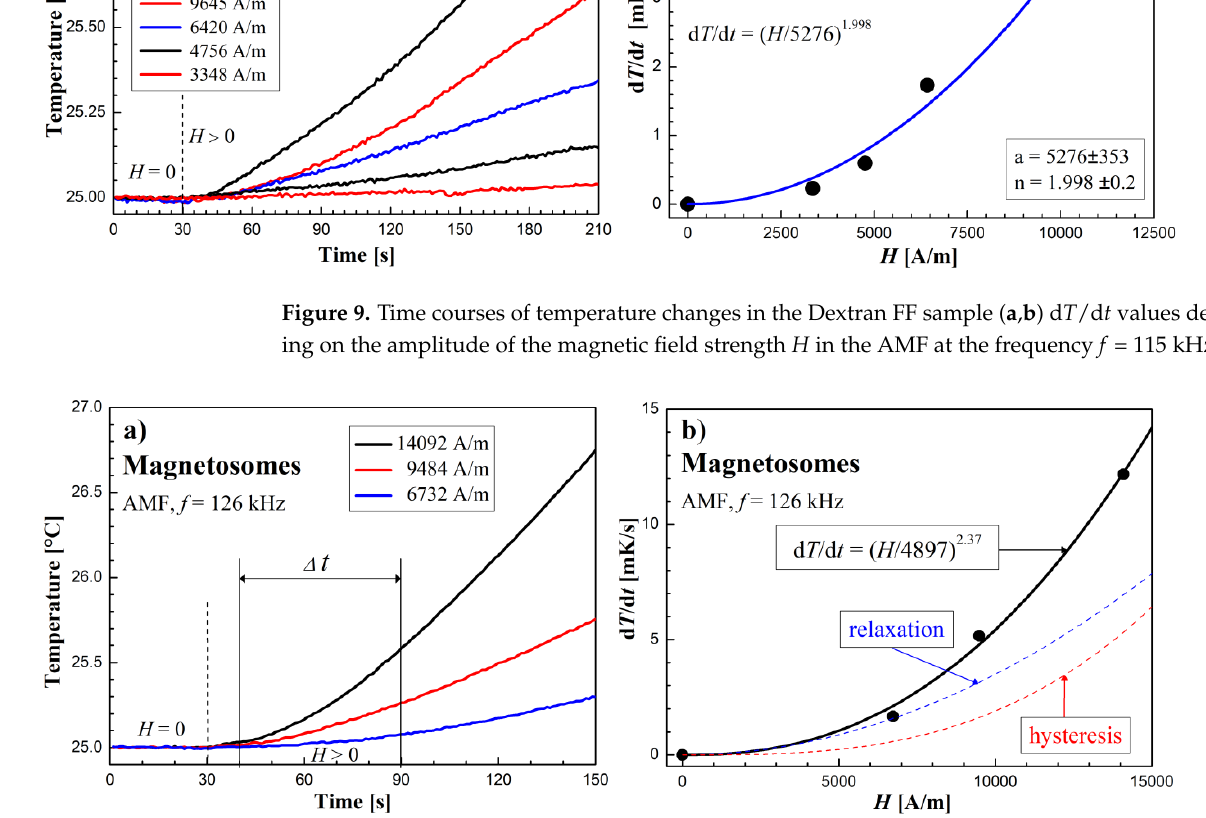
Figure 10. Time courses of temperature changes in the magnetosomes sample ( a ) and ( b ) d T /d t values depending on the amplitude of the magnetic field strength H in the AMF at the frequency f = 126 kHz.